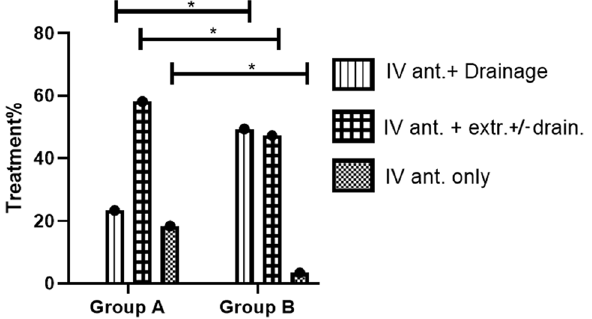
Figure 3. Medical treatment administered during hospitalization among patients hospitalized before and after (group A and B, respectively) inclusion of pediatric dental care in Israel’s National Health Insurance Law. IV ant. intravenous antibiotic, extr. Extraction, drain. drainage. *p-value < 0.05.